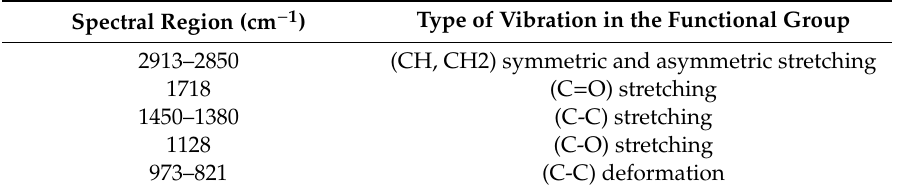
Table 4. Absorption peaks of the PHBV purified from R-NF fermented with Hfx. mediterranei DSM1411.